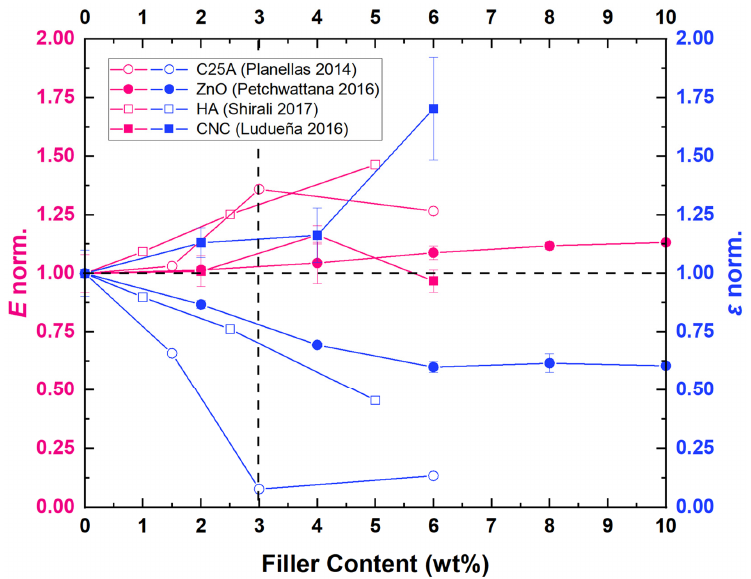
Figure 6. Variation of the elastic moduli ( E ) and elongation at break ( ε ) with filler content. For a better comparison, both parameters have been normalized to that of neat PBS. The dashed black line corresponds to a “critical” filler content.